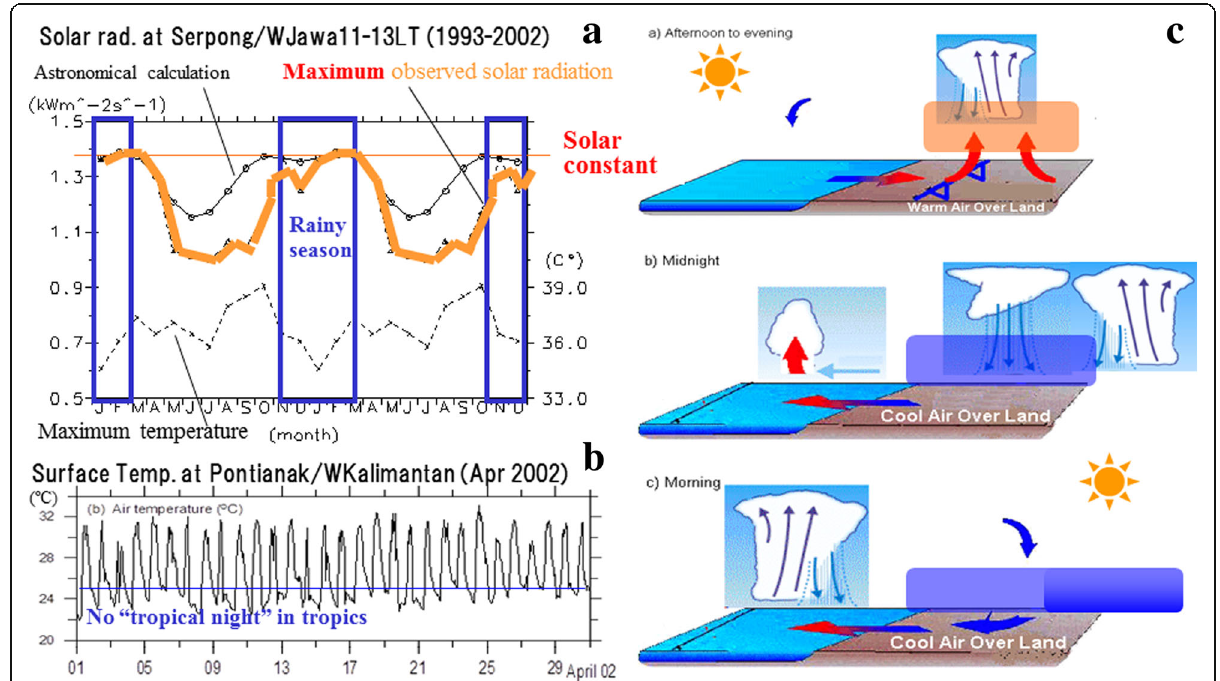
Fig. 10 a Mean annual cycle of the monthly maximum insolation at Serpong (6° S, 107° E) near Jakarta during 1993 – 2002 (Araki et al. 2006), b monthly temperature variation at Pontianak (0°, 109° E), west Kalimantan in April 2002 (Wu et al. 2008), and c mechanism (Wu et al. 2009) of the diurnal cycle over the